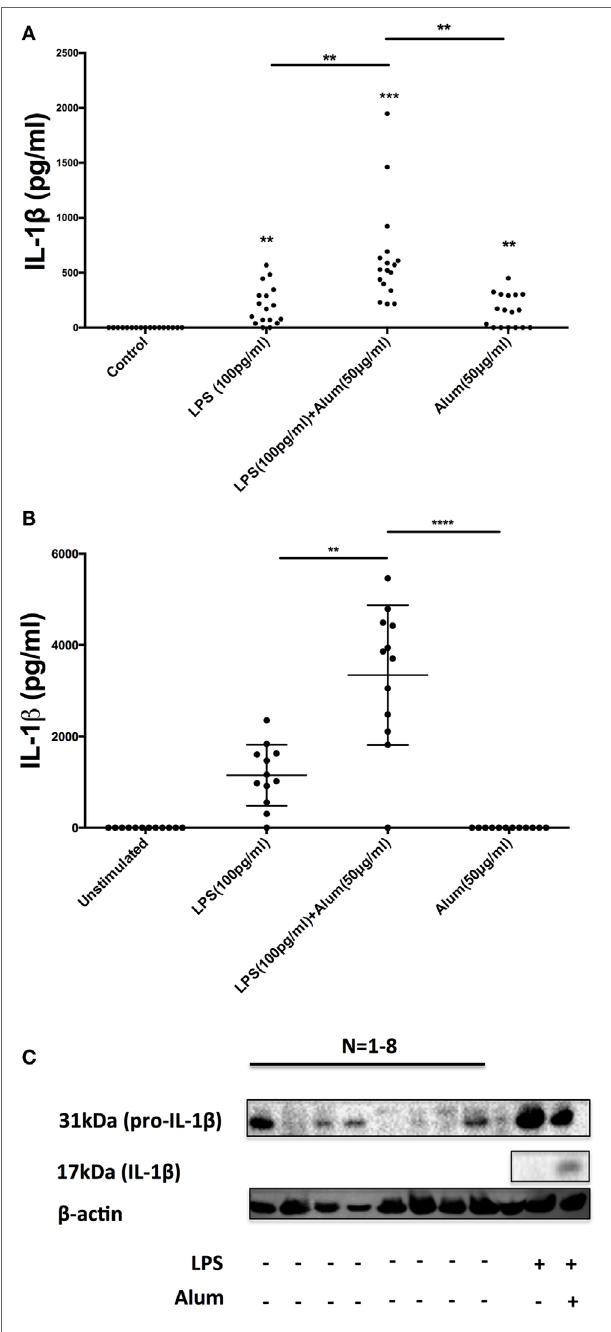
FigUre 3 | A subset of bovine, but not human, peripheral blood mononuclear cells (PBMCs) contain preformed IL-1 β . Bovine PBMCs from 17 Friesian cows were stimulated with LPS (100 pg/ml) and alum (50 µg/ml) for 24 h and tested for IL-1 β secretion by ELISA (a) . PBMCs from 12 human donors were treated with LPS (100 pg/ml) and alum (50 µg/ml) and tested for IL-1 β using ELISA (B) . Bovine cells (2 × 10 6 cells/ml) from eight cows were left unstimulated or treated with LPS and or/alum for 6 h and analyzed by western blot for pro-IL-1 β (c) . For ELISA analysis, results are mean cytokine concentrations ( + SEM) in supernatants that were tested individually in triplicate. * p < 0.05, ** p < 0.01, *** p < 0.001 were calculated using